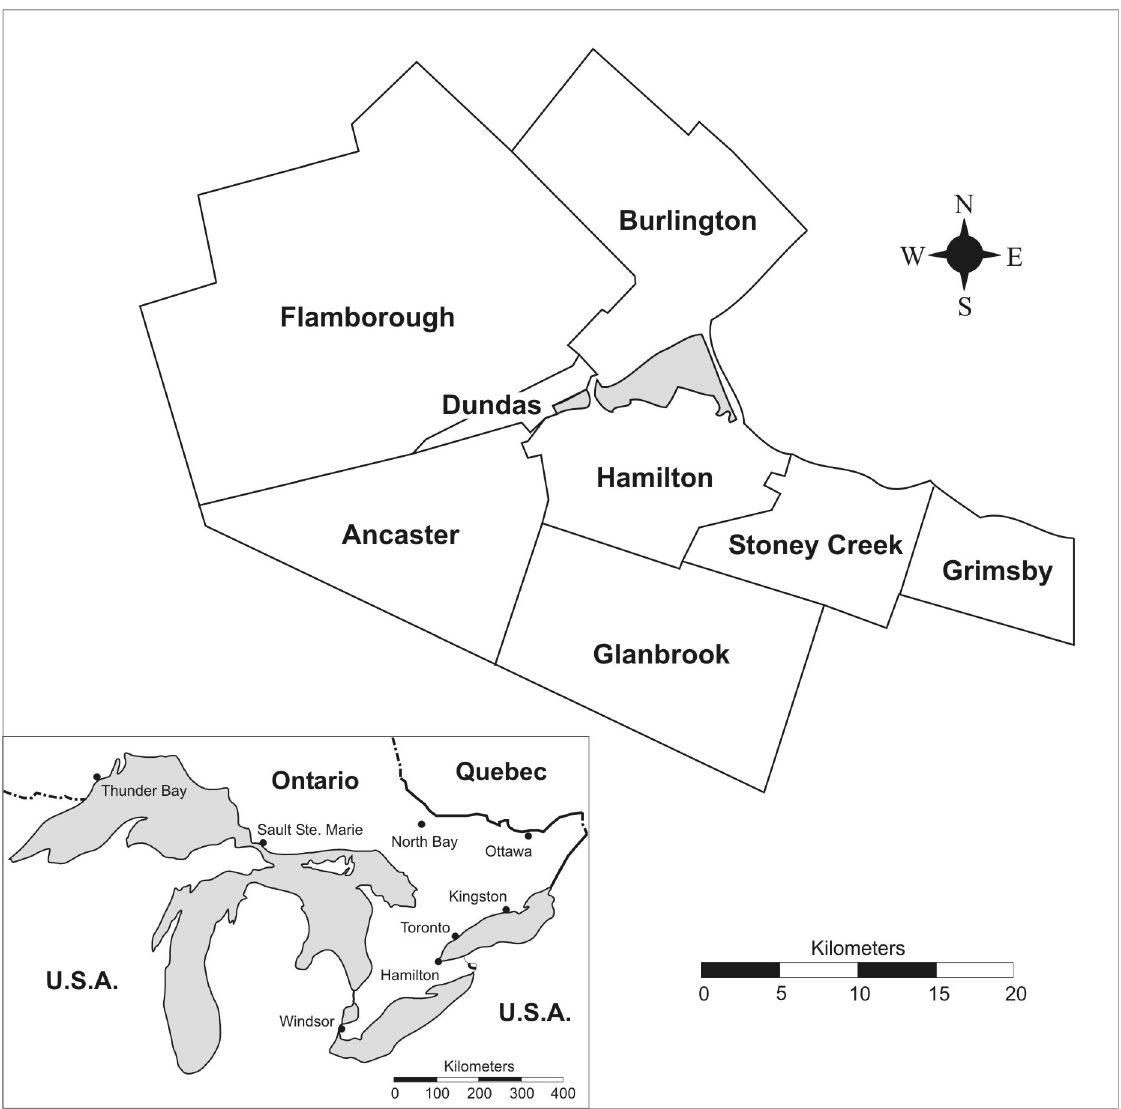
Figure 1. Municipalities in the Hamilton